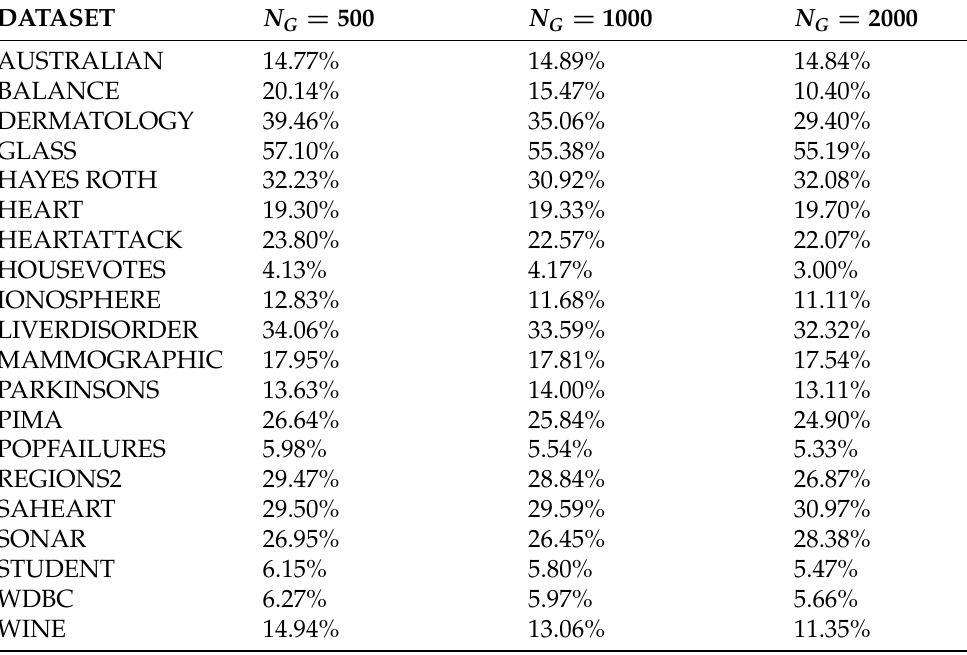
Table 4. Experiments with the number of generations for the classification